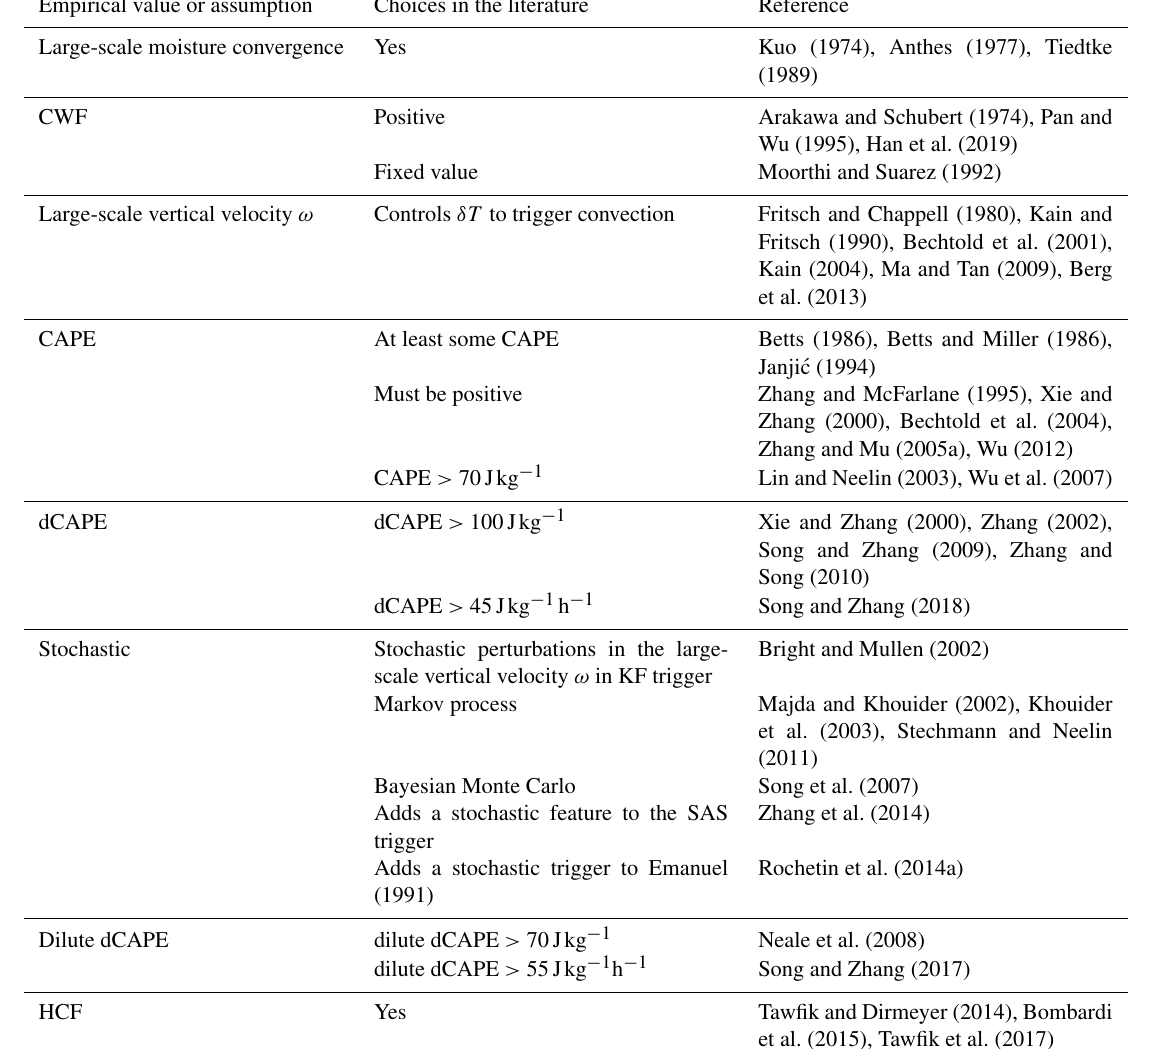
Table 2. A sample of empirical values and assumptions used in the main trigger function